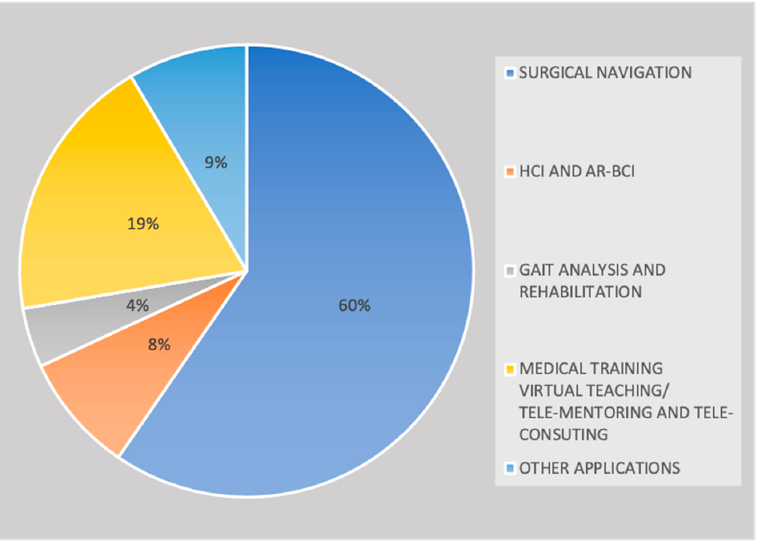
Figure 4. Reviewed publications related to HoloLens 2 research by sub-field applications.